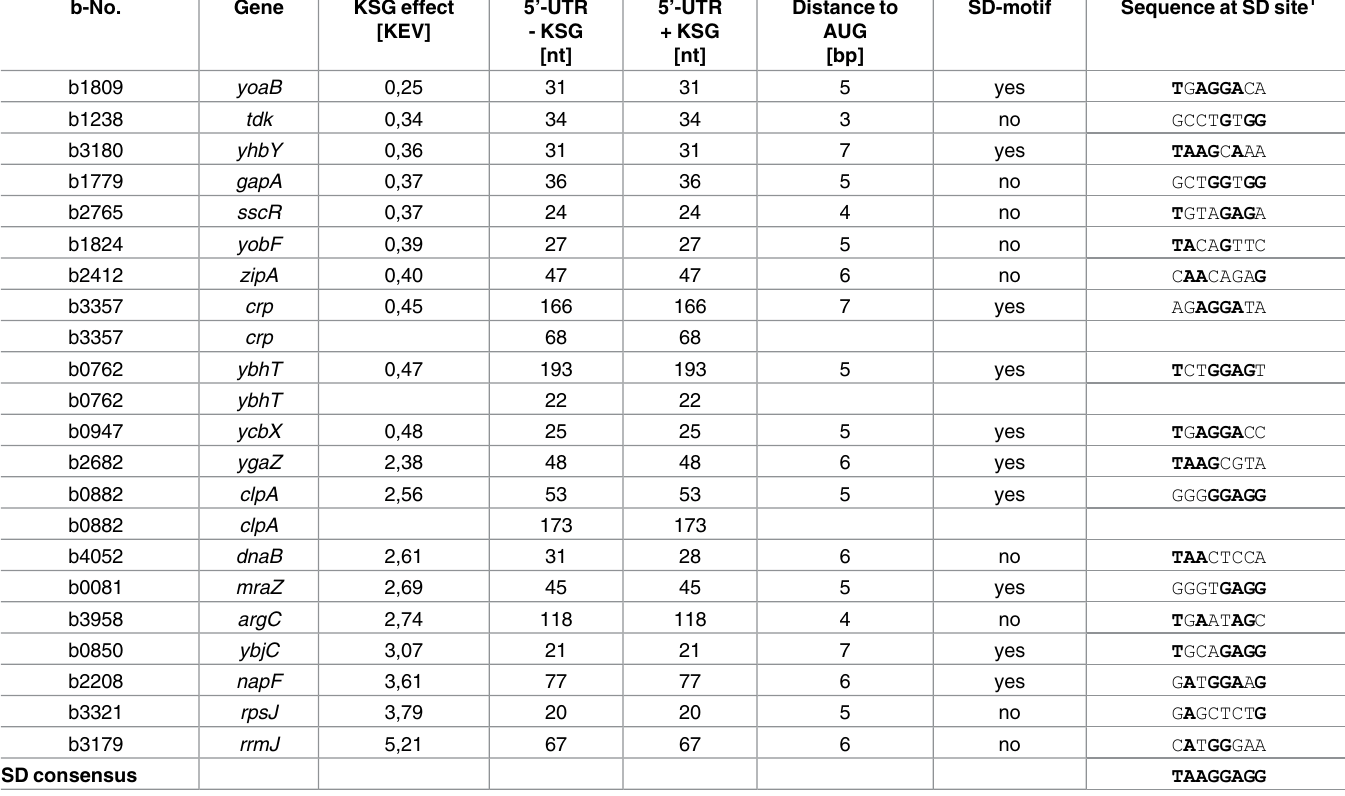
Table 1. Transcripts with experimentally-determined 5’-ends and selected features.